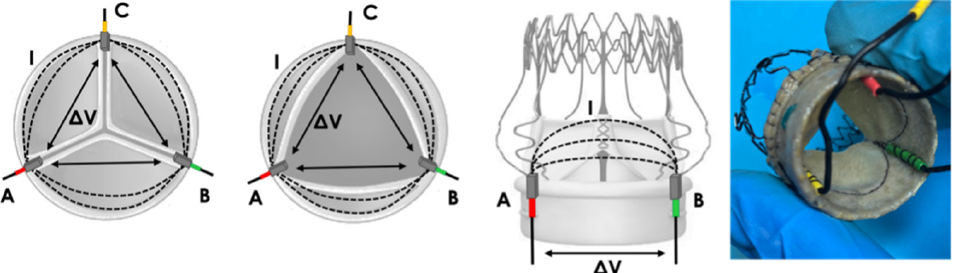
Figure 3. Prototype 1: positioning of “mini ‐ platelet” electrodes A (red), B (green) and C (yellow). Local electric field lines (I) and the corresponding potential difference measurement ( Δ V) are represented for each pair of electrodes.